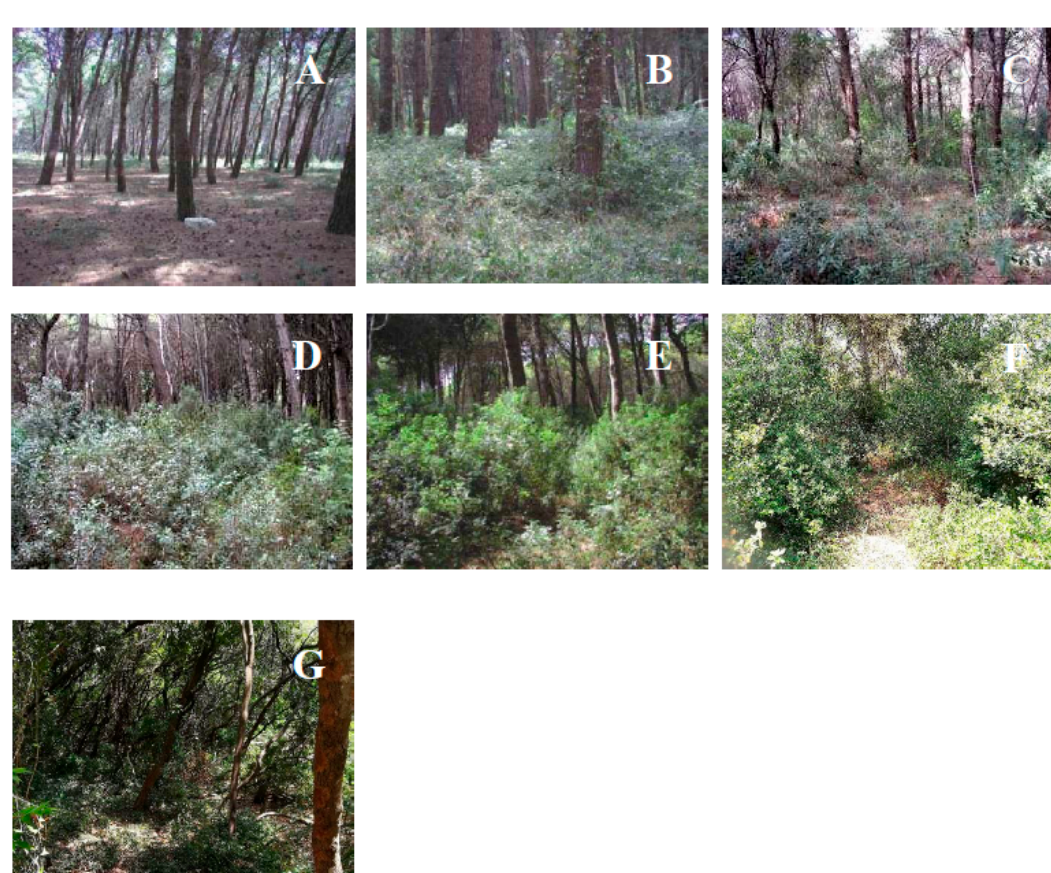
Figure 4. Images ( A – E ) were taken in 2006, in the afforested area, showing an increasing development of the understory, associated with decreasing levels of canopy cover. Image ( F ) was taken in 2019, showing the transition from understory to overstory. Image ( G ) was taken in 2019 in a nearby reserve not afforested with P. halepensis , where ecological succession along 40 years has resulted in the development of a broadleaf forest dominated by Quercus coccifera , Quercus ilex and Arbutus unedo .